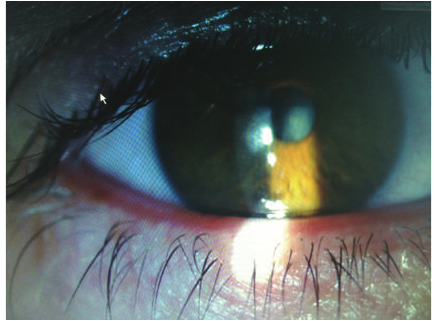
Figure 3: Preoperative SOCT anterior of the right eye.